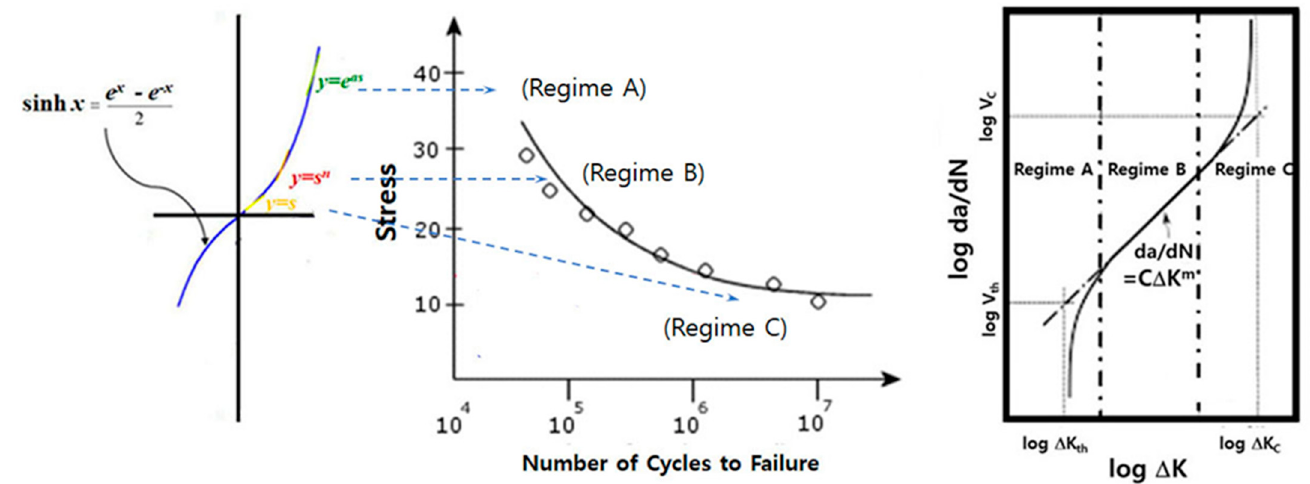
Figure 6. Definition of the hyperbolic sine stress expression on the Paris law and S ‒ N curve.